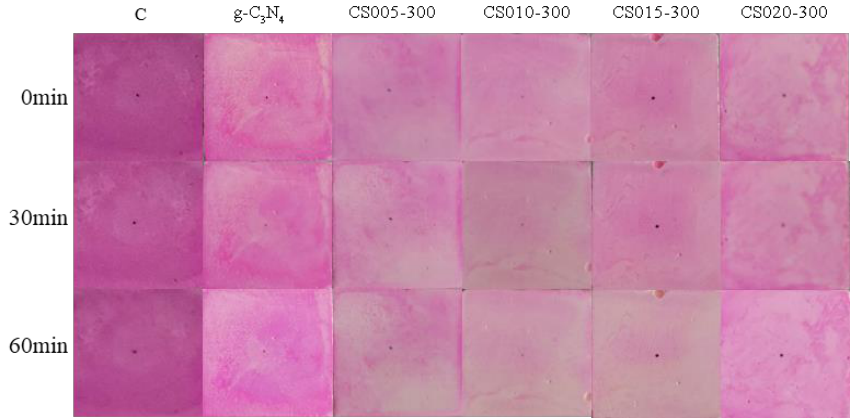
Figure 12. Photocatalytic performance of surface treatment cement by the brushing method.